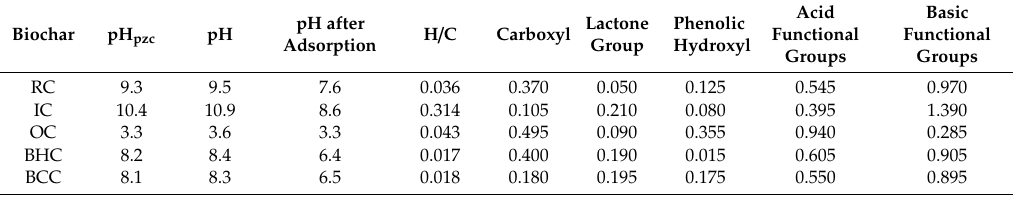
Table 1. Physicochemical properties and the number of surface functional groups of biochar (mmol / g). Biochar pH pzc pH